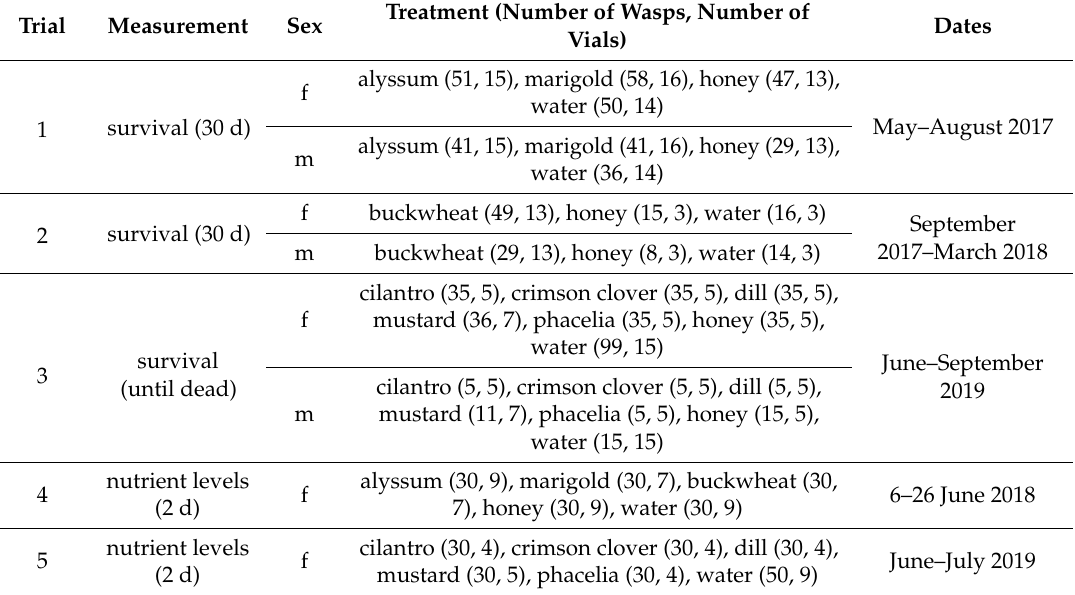
Table 1. Summary of trials. Newly emerged, unfed wasps were placed in vials with each treatment and evaluated for 30 d (trials 1 and 2) or until all wasps were dead (trial 3). For nutrient trials, wasps were fed for 48 h and nutrients were measured using anthrone and vanillin assays adapted for Trissolcus japonicus . Treatment (Number of Wasps, Number of Trial Measurement Sex Vials)